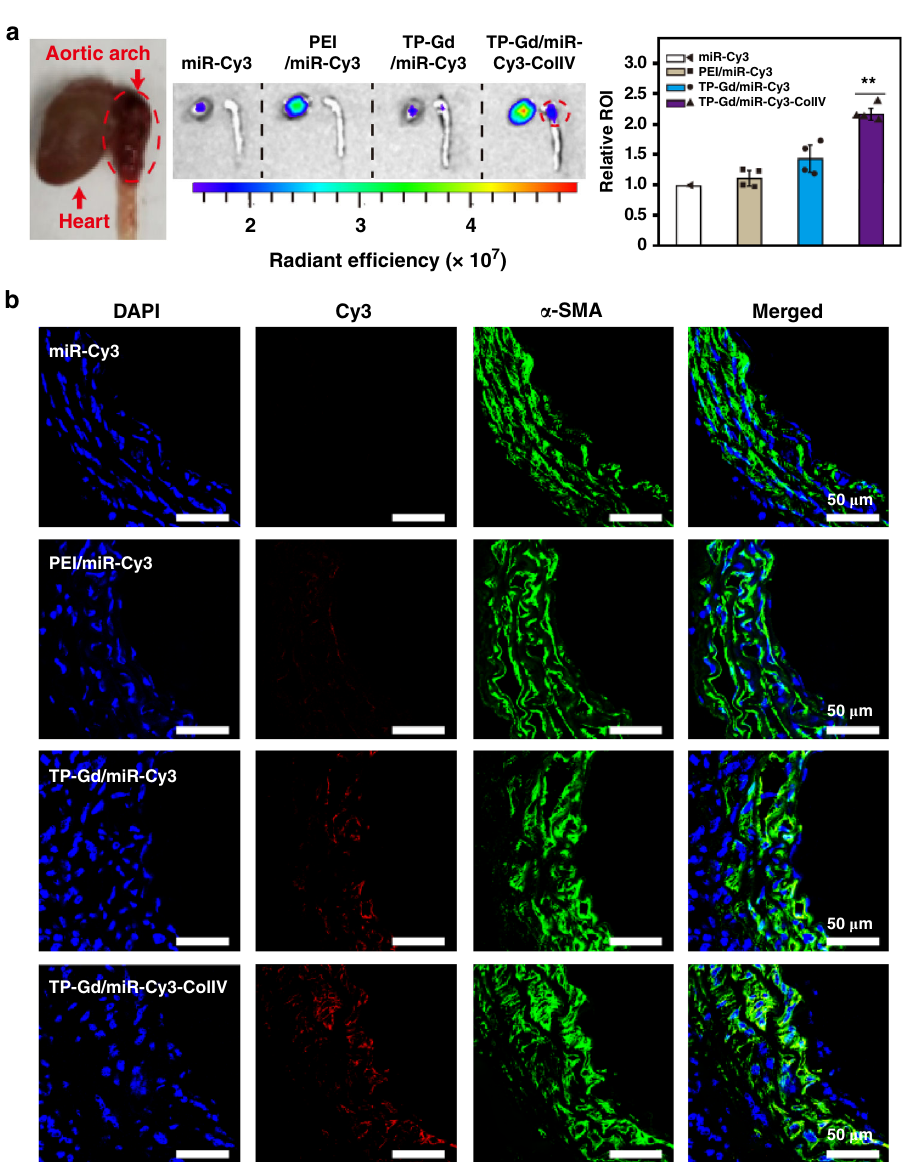
Fig. 4 a Representative images and relative ROI of thoracic aorta with early dissection after the accumulation of miR-Cy3 and polycation/miR-Cy3 complexes determined by Xenogen IVIS imaging system (** p < 0.01, see “ Statistical analysis ” in “ Methods ” ; source data are provided as a Source Data fi le). b In vivo fl uorescent images of accumulated miR-Cy3 in mouse thoracic aortic arch. ( n ≥ 3 animals; error bars represent standard